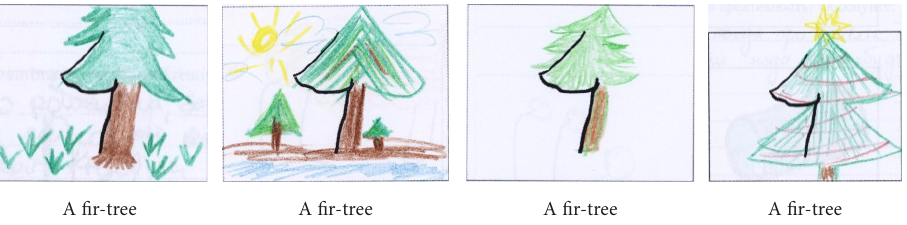
Figure 19. The creative task: interpretation of Fragment 3 – plants: fir-trees (source: testingmom.com,